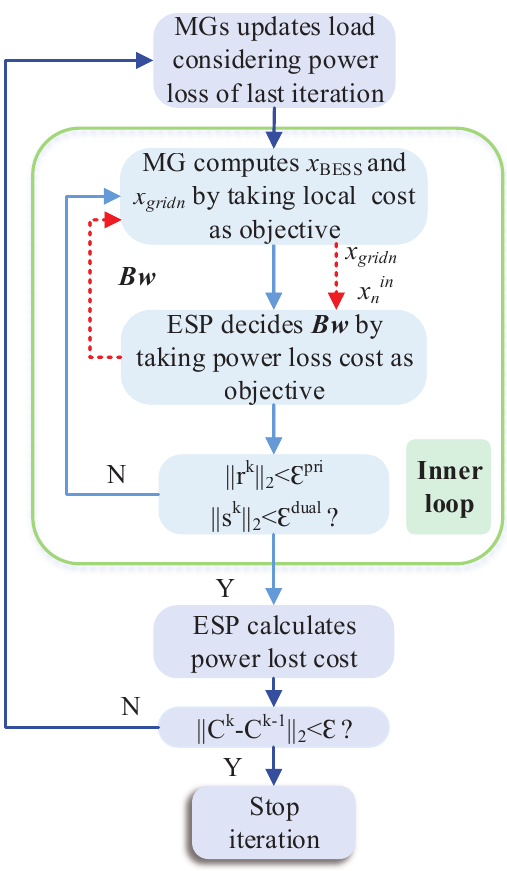
Figure 2. The bidirectional interaction flowchart between MGs and